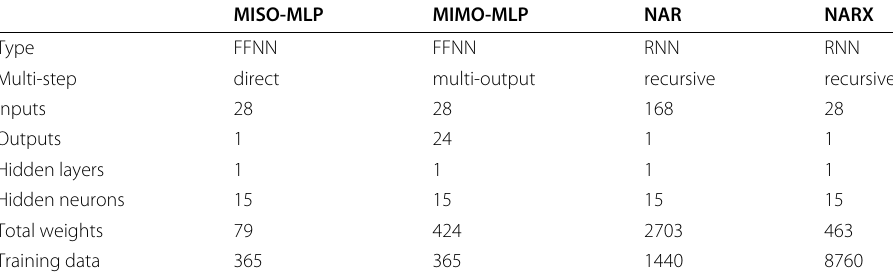
Table 2 Network setup